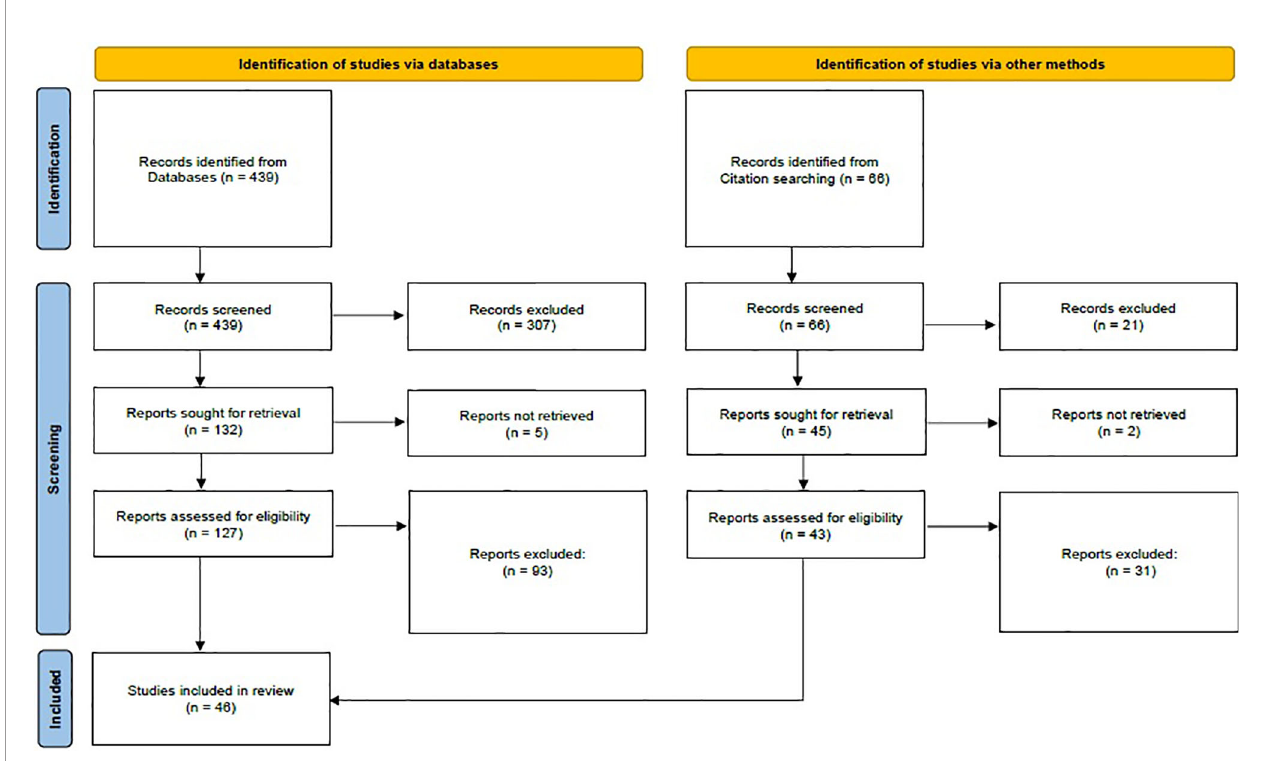
FIGURE 1 | PRISMA fl ow diagram. Adapted from Page et al.